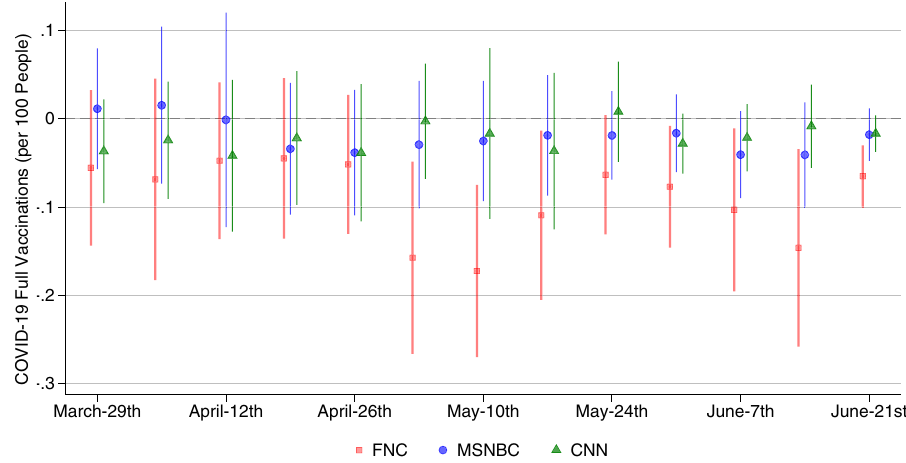
Figure 1. Cable news viewership and weekly vaccination rates, 2021. Coefficient plots with 95% CIs from OLS regressions looking at the association between one standard deviation changes in viewership on weekly vaccinations per 100 people. Regressions include demographic and cable-system controls. Standard errors are clustered by